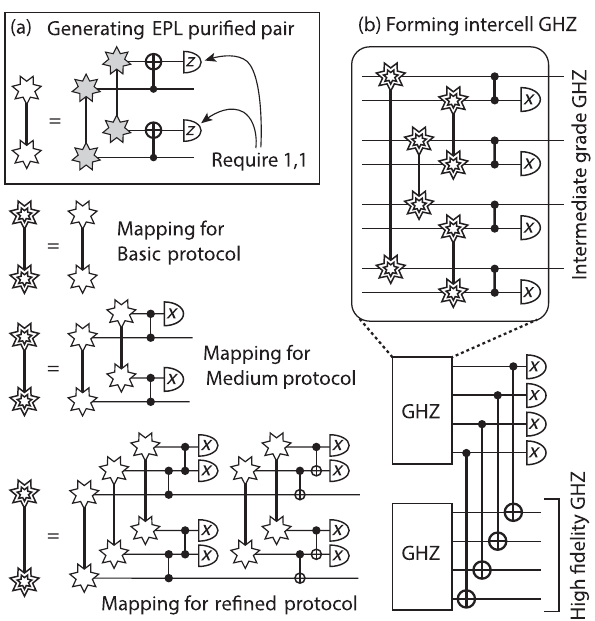
FIG. 3. Distilling a GHZ state with EPL-generated entangle- ment. (a) The symbols with gray-shaded stars represent the highly mixed Bell states ρ or ρ 0 obtained when a single detector raw raw “ click ’ is seen. Following the the extreme photon loss protocol [26], we can combine two such pairs and measure one out, thus producing a single greatly improved pair. This process is represented by a symbol with an open star. (b) Circuit diagram showing the adapted GHZ distillation process for entanglement generated using the EPL protocol. Two GHZ states are produced and one is used to make a four-qubit parity projection onto the other. The three different protocols, basic, medium, and refined are